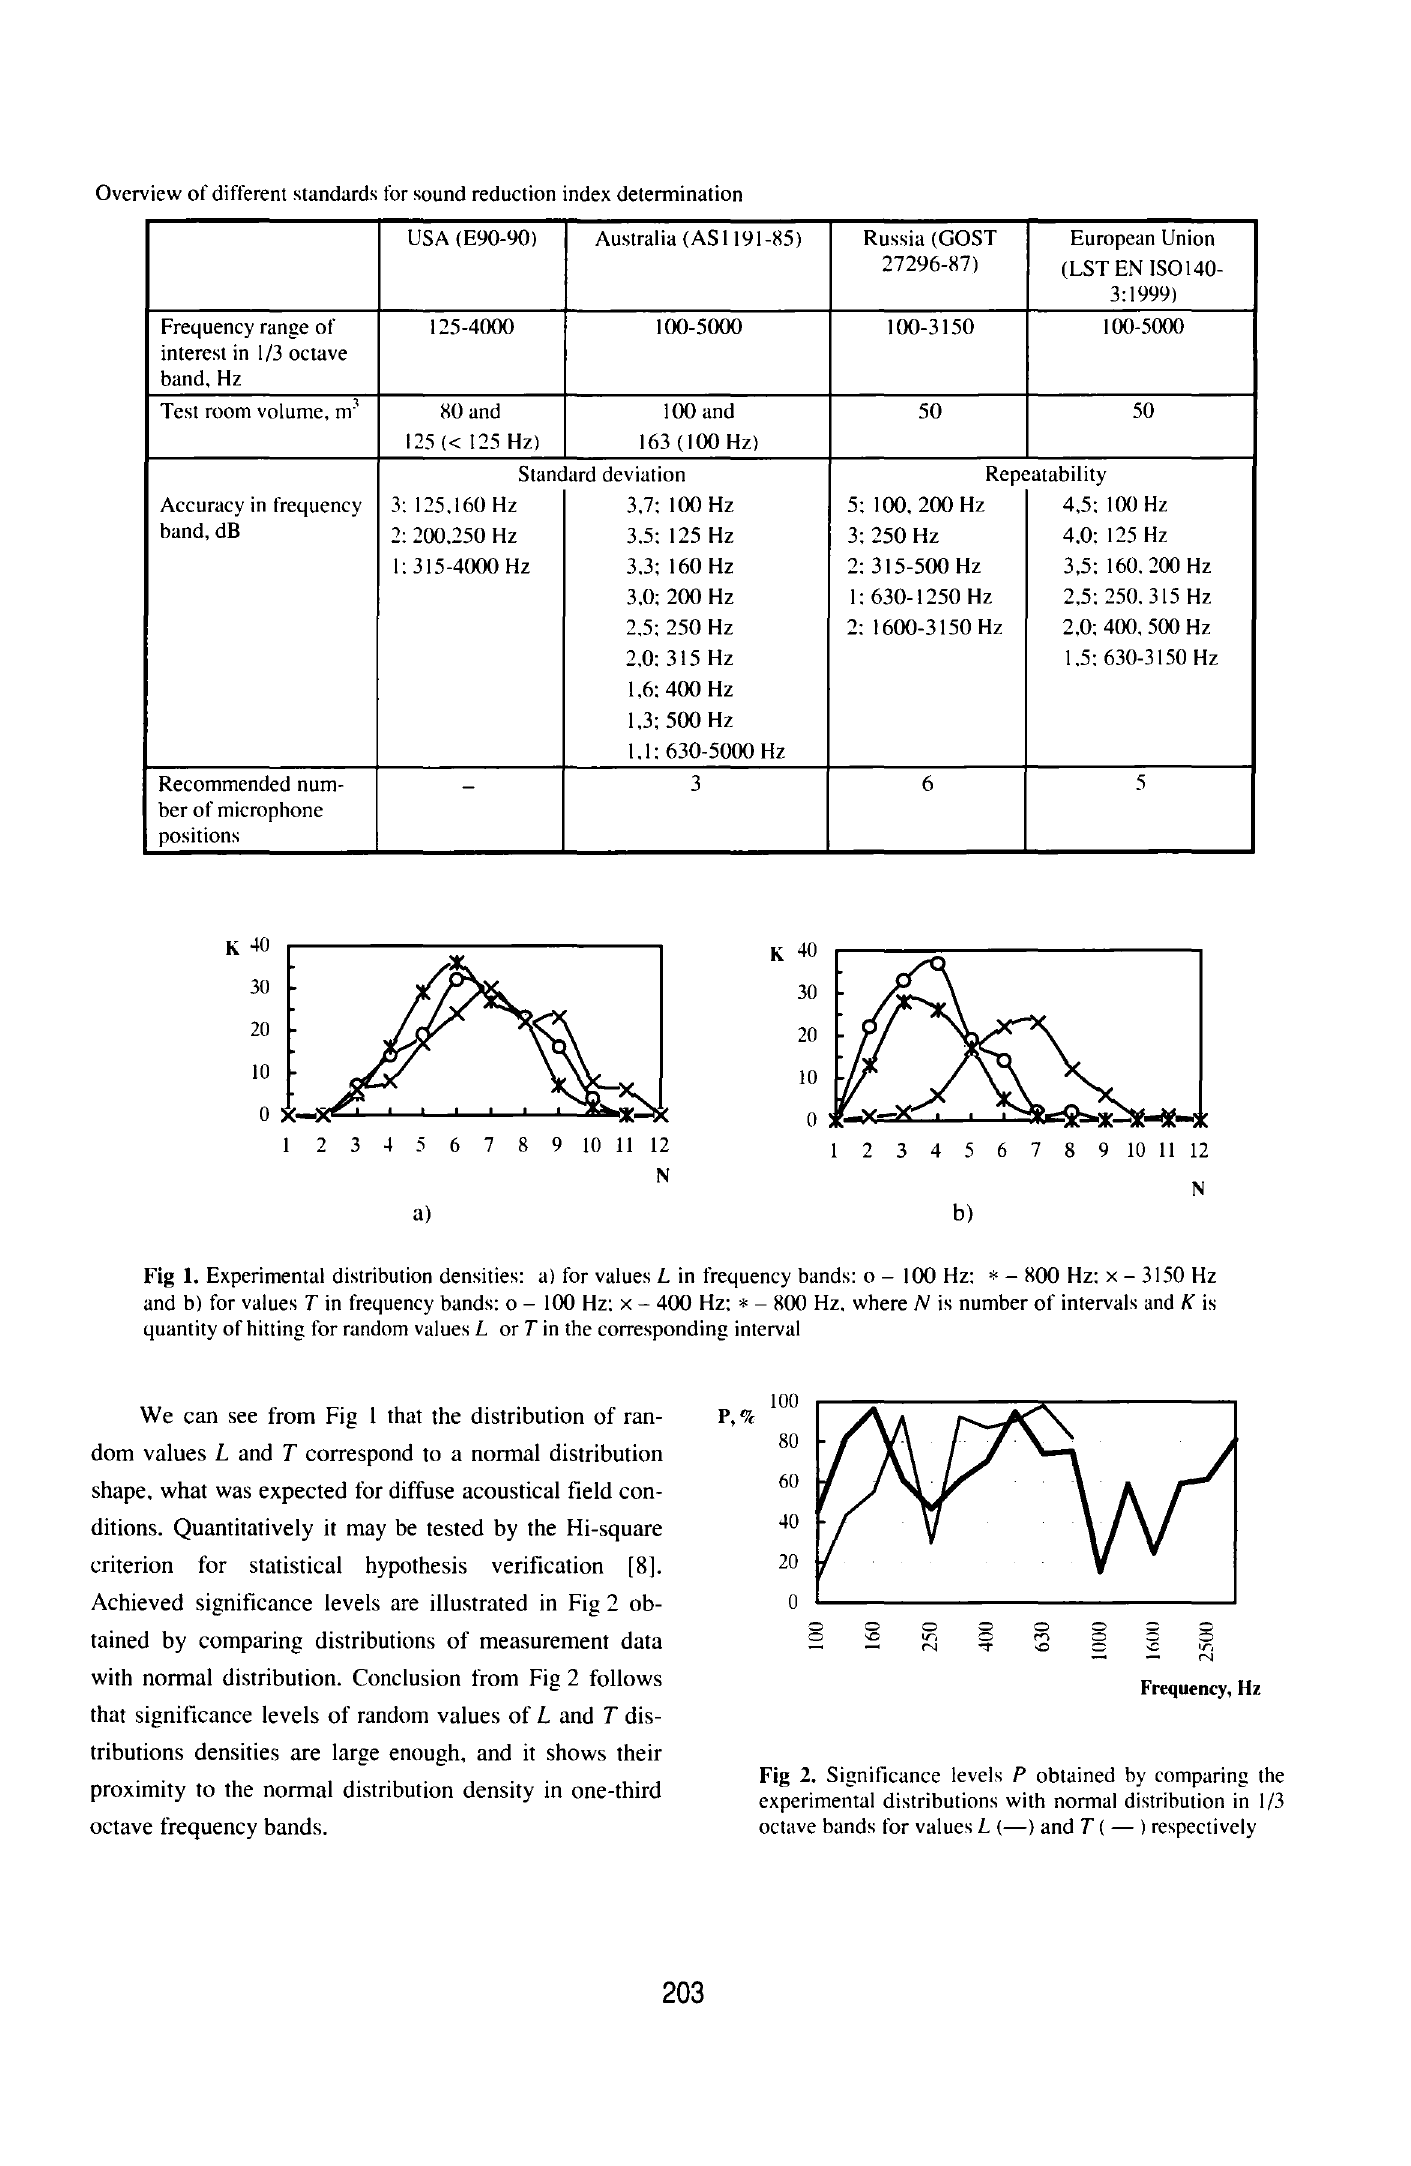
Fig 2. Signiticance levels P obtained by comparing the experimental distributions with normal distribution in 1/3 octave bands for values L (-)and T